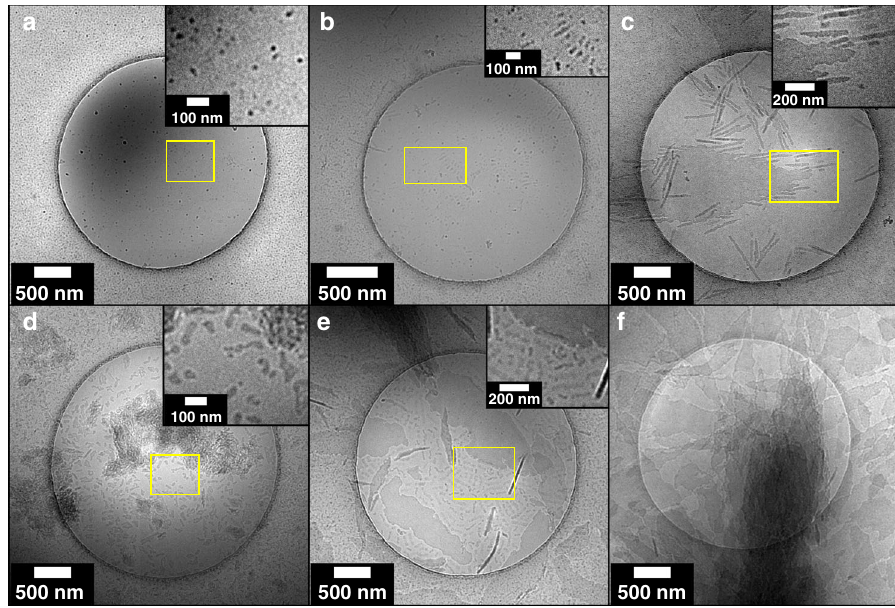
Fig. 3 Morphological evolution by cryo-TEM. a – c PLLA 45 - b -PEG 45 (10% solids w/w 9), a = 1 h, b = 6 h, c = 24 h. d – f PLLA 90 - b -PEG 45 (10% solids w/w 15), d = 5 min, e = 3 h, f = 6 h. The data show two distinct assembly mechanisms that appear to be a result of unimer addition (sample 9) and particle aggregation (sample 15), resulting in lamellae with different